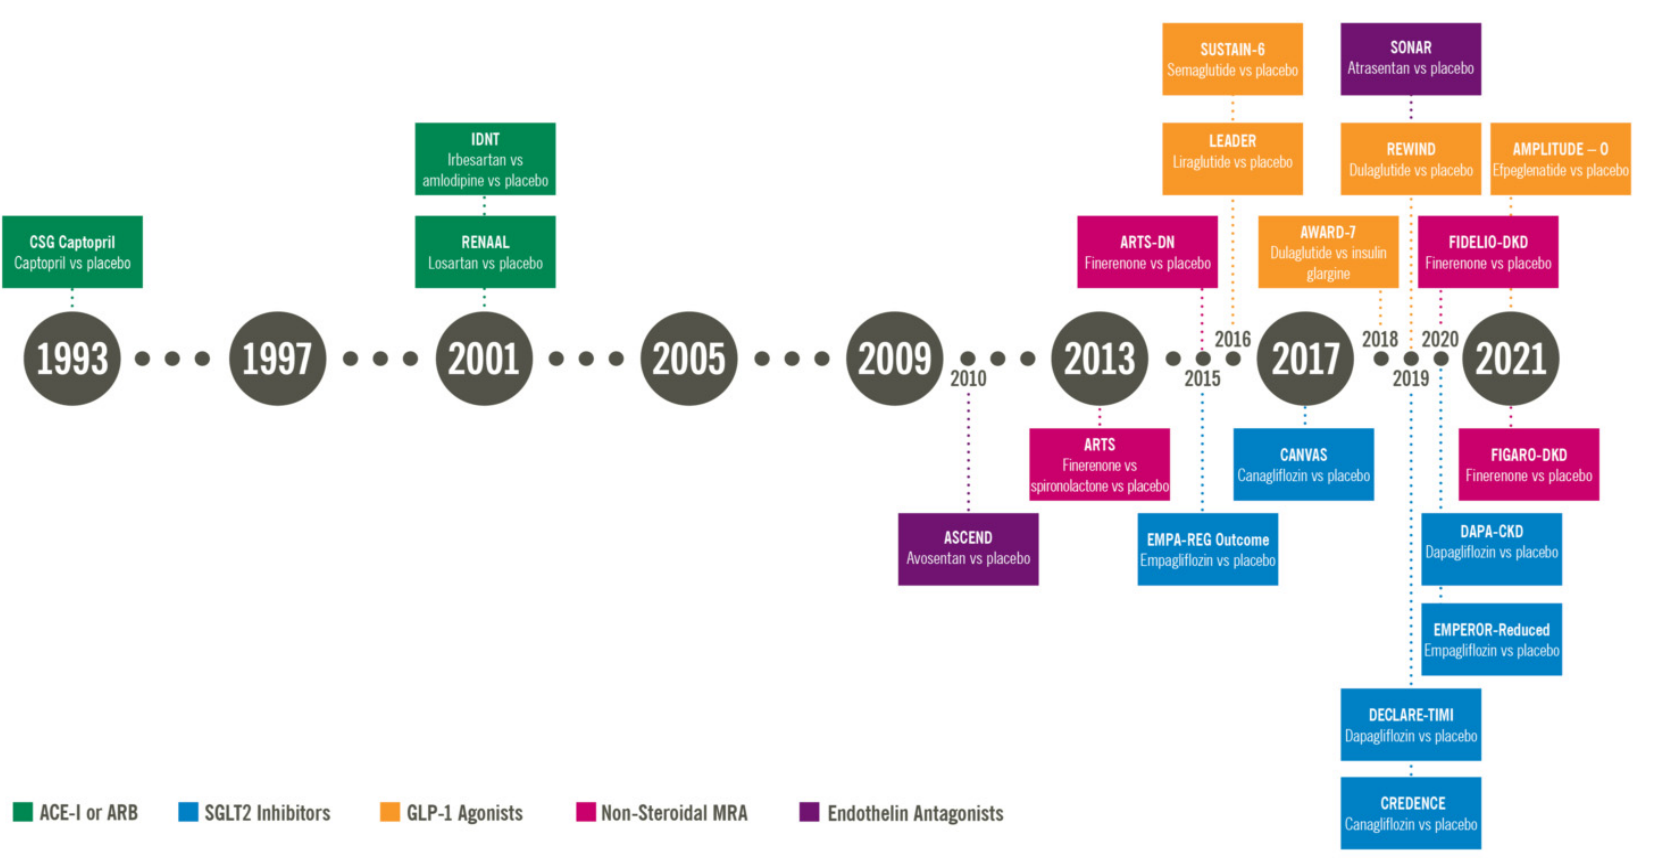
Figure 1. Timeline showing the landmark trials for diabetic kidney disease (DKD). The drug classes depected are angiotensin converting enzyme (ACE) inhibitors and angiotensin receptor blockers (ARB), sodium glucose transport protein 2 (SGLT2) inhibitors, glucagon like peptide 1 (GLP-1) agonists, non-steroidal mineralcorticoid receptor antagonists (MRA) and endothelin antagonists.